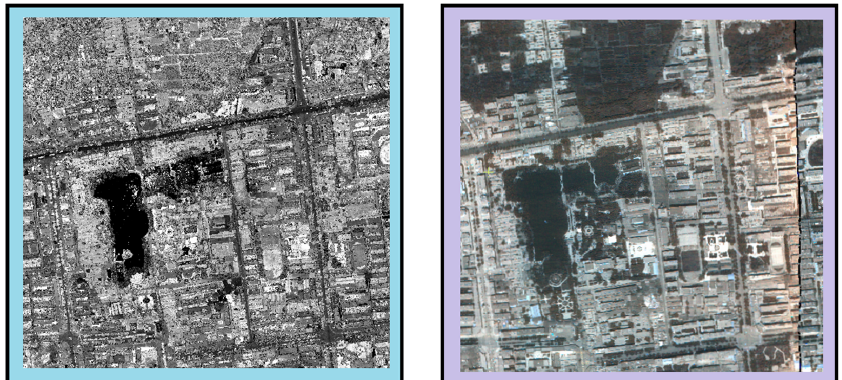
Figure 5. Airborne LiDAR data. On the left is a display of the LiDAR point cloud data in Zhangye, Gansu, China, according to its intensity information, and on the right is a CCD aerial image of the corresponding area. In the airborne LiDAR data, there are three main types of trees in terms of their spatial distribution: individual trees, street trees aligned in a row, and trees in a cluster formation.